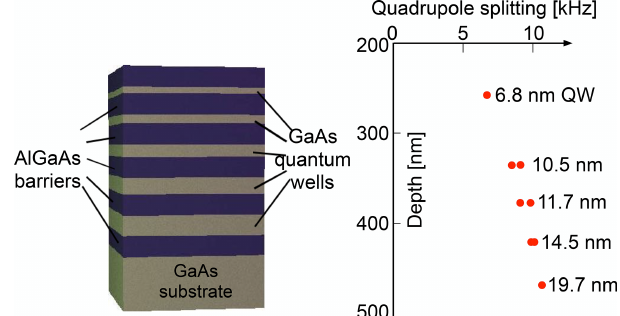
Figure 30. Variation of the quadrupole splitting with the distance from the sample surface.